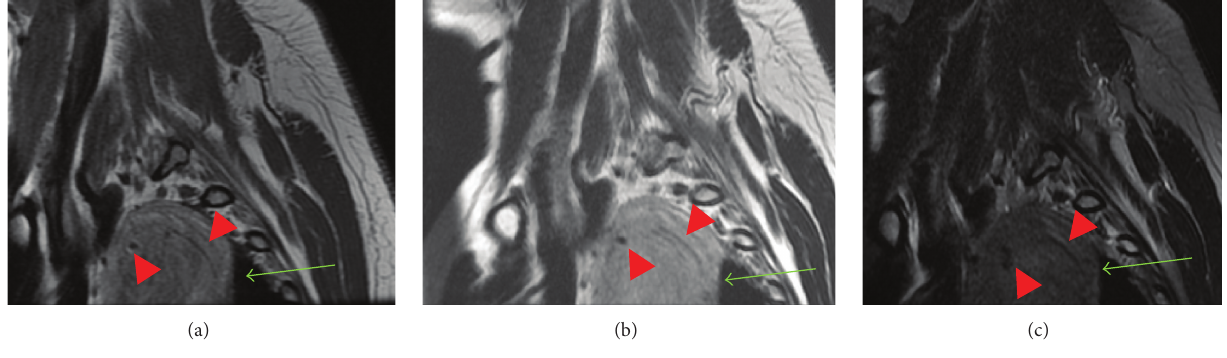
Figure 3: Sagittal T1 (a), T2 (b), and fat saturation T2 (c) weighted images from the cervical spine MRI show a heterogeneous, T1, and T2 hyperintense mass (green arrows in (a) and (b)) with a few internal flow voids (red arrow heads in (a), (b), and (c)) and moderate loss of signal with fat saturation (green arrow in